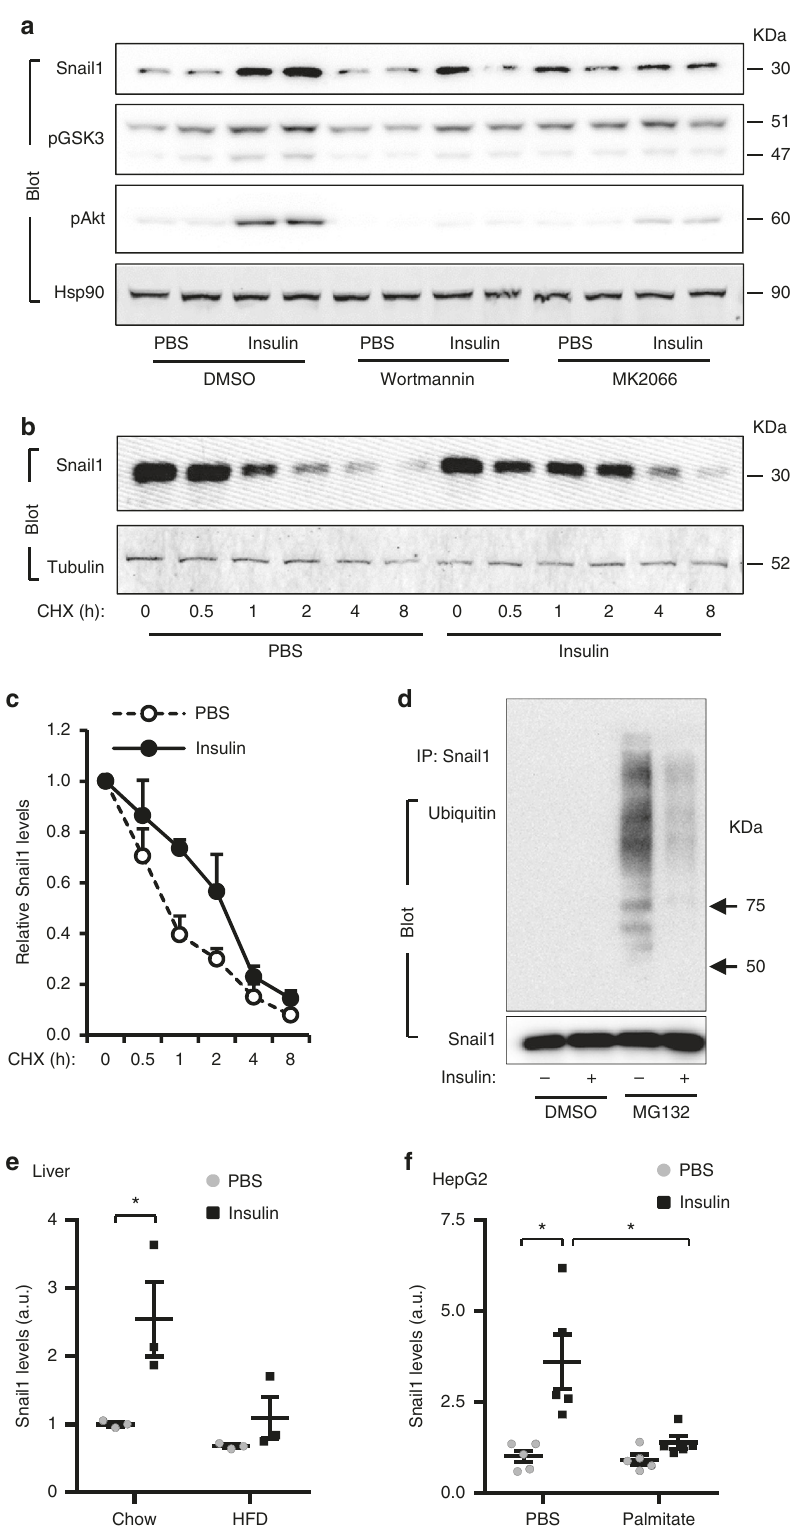
Snail1 Δ hep and Snail1 fl ox/ fl ox littermates (Supplementary Fig. 3a, b). Hepatocyte lipid droplets were larger and more abundant in Snail1 Δ hep mice relative to Snail1 fl ox/ fl ox littermates, as assessed by staining liver sections with neutral lipid dye Nile red (Fig.